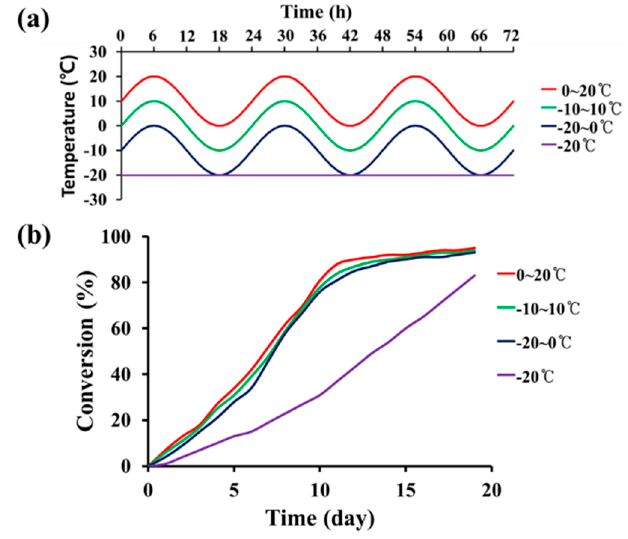
Figure 2. ( a ) Temperature conditions for STP/DD reaction; ( b ) Reaction conversion of silanol groups versus time at each temperature condition.